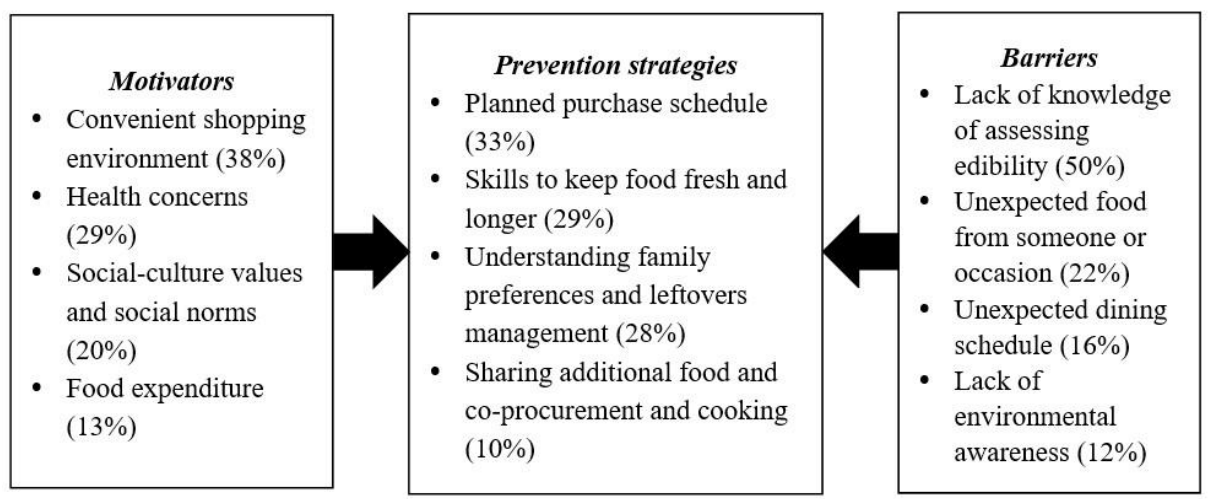
Figure 1. Determinants and strategies for household food waste reduction. Note: The number in parentheses denotes the percentage of frequency obtained from content analysis.